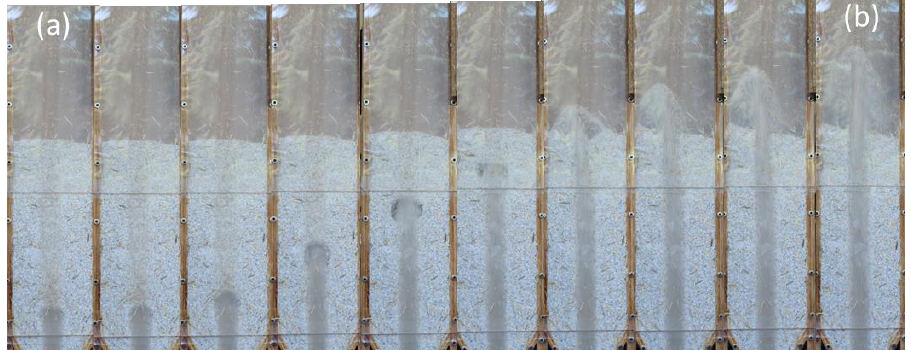
Figure 1. Stages of spouting: from static bed ( a ) to a fully developed spouting regime ( b ).